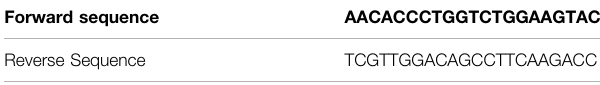
TABLE 1 | The primer sequences utilized in real-time PCR. Forward